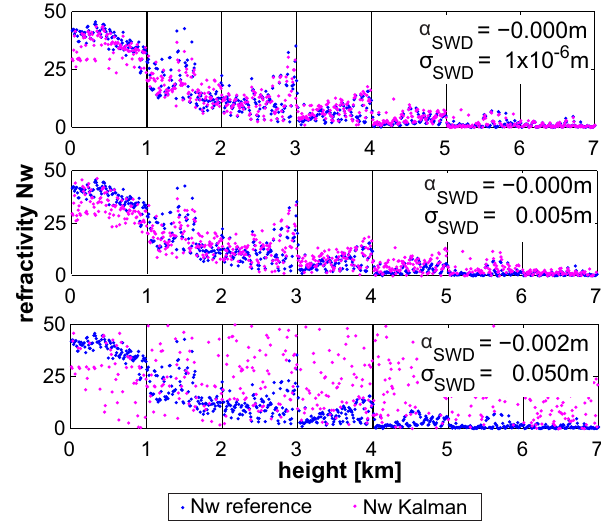
Fig. 14. The selected solution for one epoch, with different magni- tude of applied noise, from top to bottom zero, intermediate, realis-